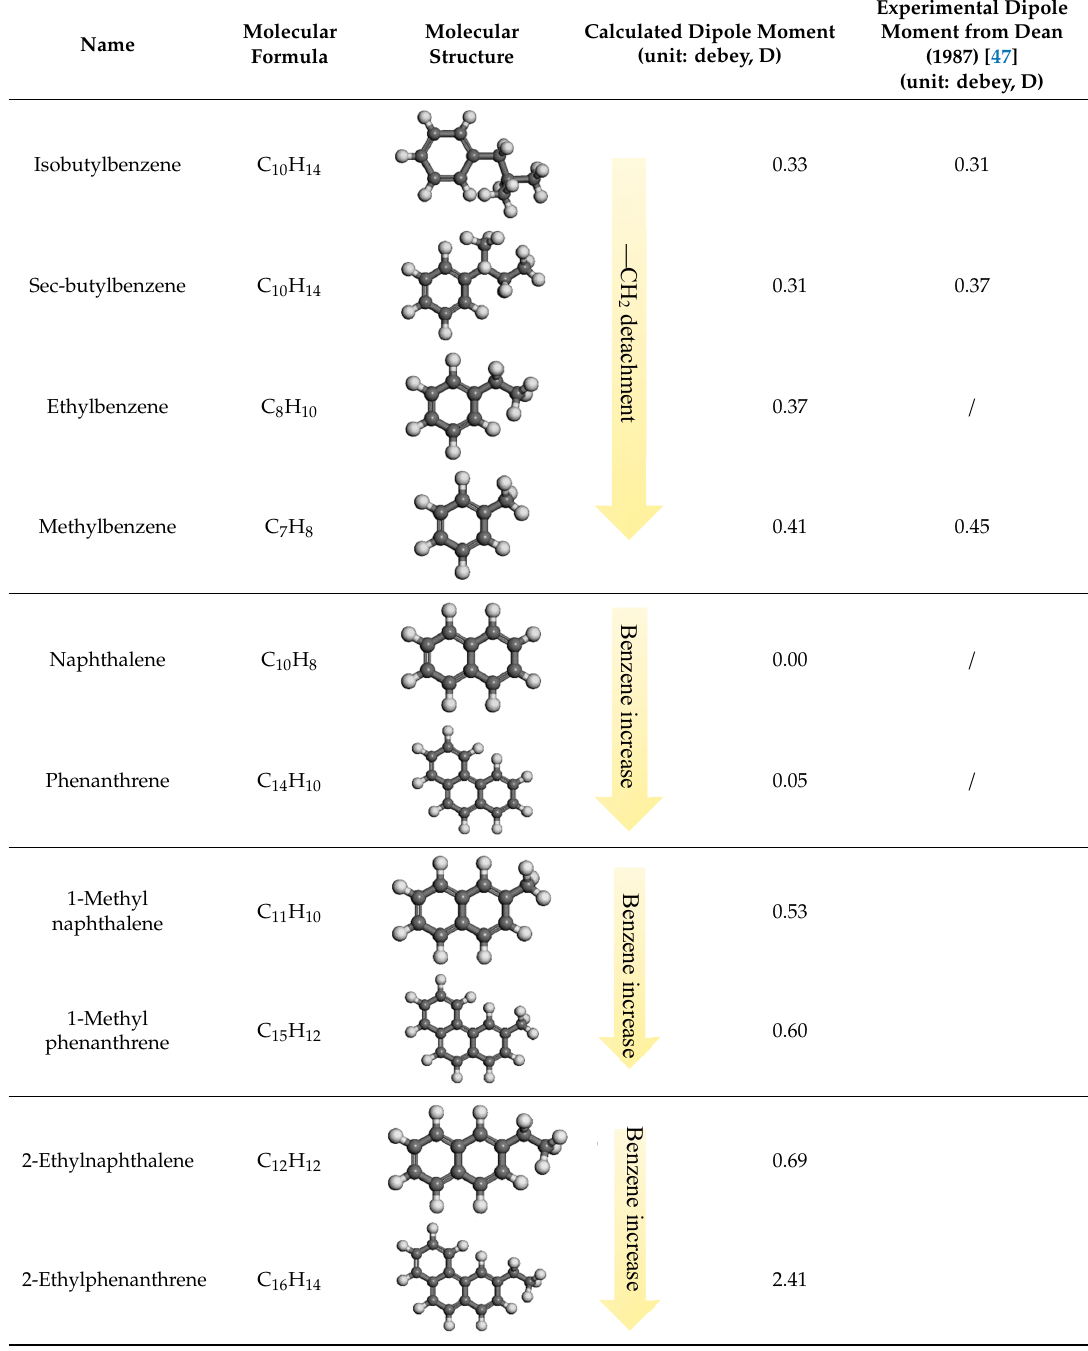
Table 4. Calculation results of dipole moment for typical organic molecule.